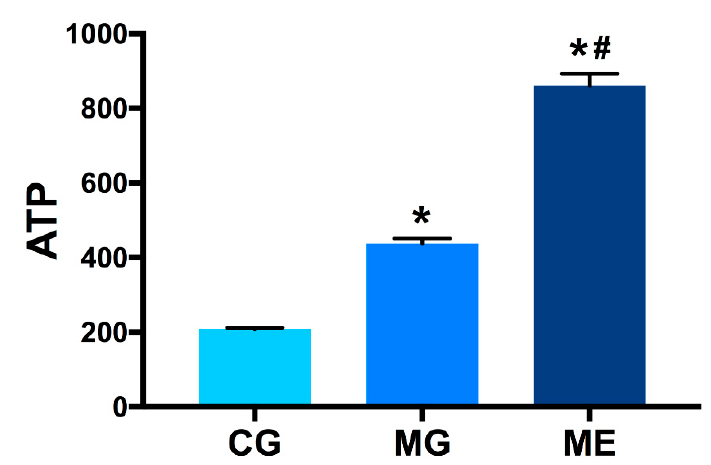
Figure 5. Content in skeletal muscle tissue homogenate. Control Group = CG, Model Group = MG, and Model Exercise Group = ME.* indicates p < 0.01 compared with CG; # indicates p < 0.01 compared Figure 5. content in skeletal muscle tissue homogenate.Control Group =CG, Model Group =MG, and 205 with Model Exercise Group =ME.* indicates p < 0.01 compared with CG; # indicates p ＜ 0.01 compared with 206 MG. 207